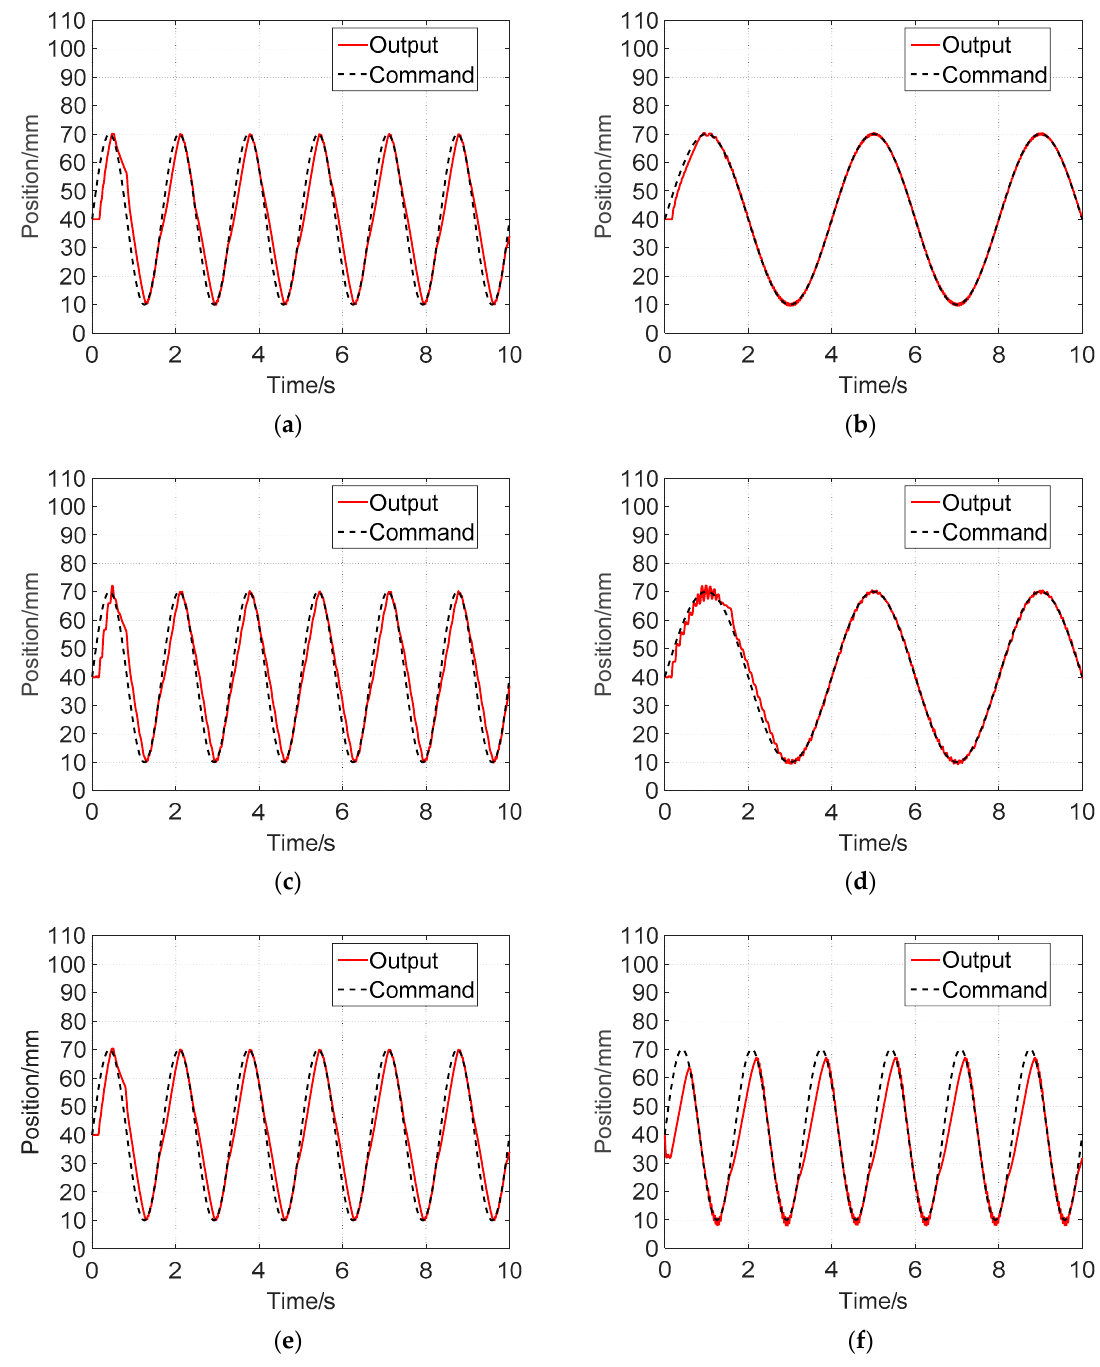
Figure 27. The simulation results in sine control using the delay compensation control method. ( a ) k f = 250 with 0.63 Hz. ( b ) k f = 125 with 0.25 Hz. ( c ) k f = 250 with 0.63 Hz and 10 Hz sine load applied. ( d ) k f = 125 with 0.25 Hz and 10 Hz sine load applied. ( e ) k f = 250 with 0.63 Hz and temperature 0 ◦ C. ( f ) k f = 250 with 0.63 Hz and 5 MPa load applied. It can also be seen from Figure 27e that the change of temperature and load has